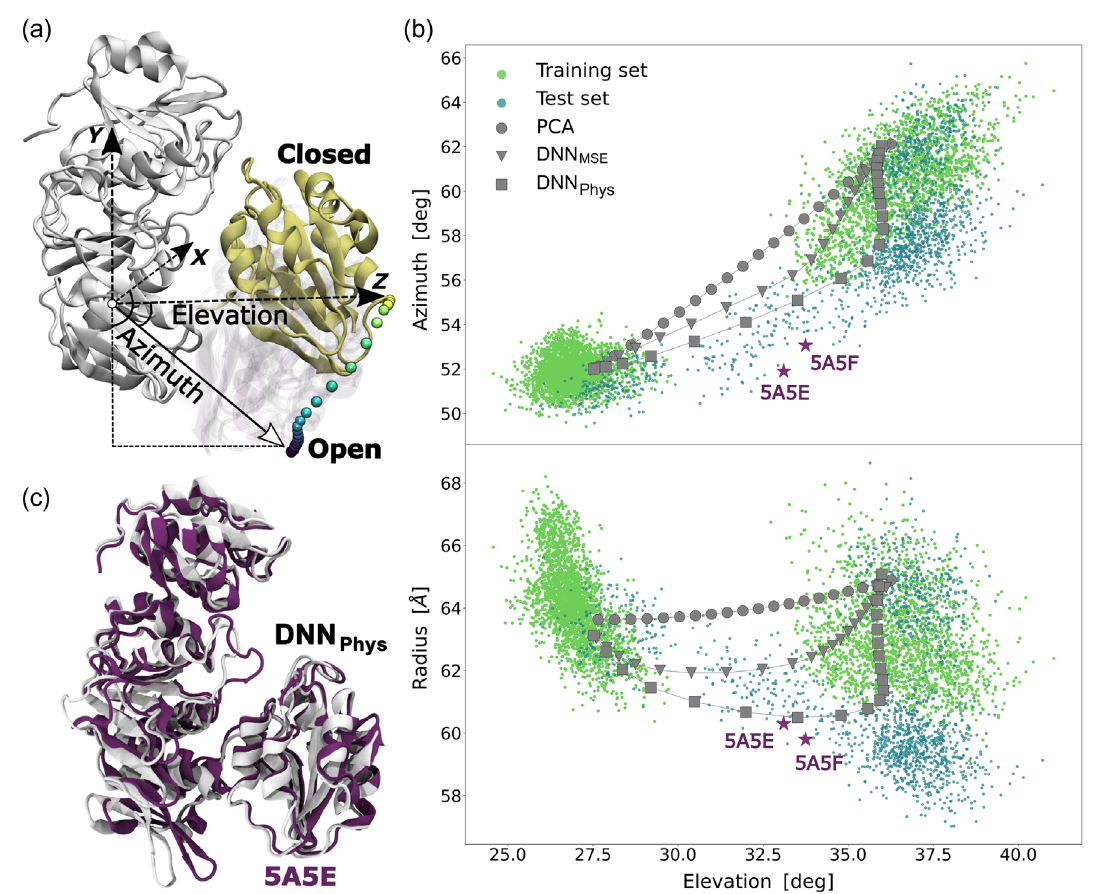
FIG. 4. State transition path prediction by the neural network. (a) Side view of MurD showing the transition of its mobile domain from the closed to open state (with the time evolution marked as beads colored from yellow to violet). (b) The conformational change of MurD can be described in terms of spherical coordinates between its three domains (see Methods). We report the opening angle of each conformation in the training set (light green), test set (dark green), intermediate crystal structures (palatinate stars), as well as interpolations generated by PCA (gray circles), purely geometry-based neural network (DNN , gray triangles), and neural network MSE combining geometry and physics (DNN , gray squares). The interpolation produced by DNN best reproduces the path described Phys Phys by the test set and transits in the vicinity of intermediate crystal structures. (c) Superimposition of intermediate MurD conformation 5A5E (in palatinate) and an intermediate conformation generated by the neural network (in white), with a RMSD of 1.3